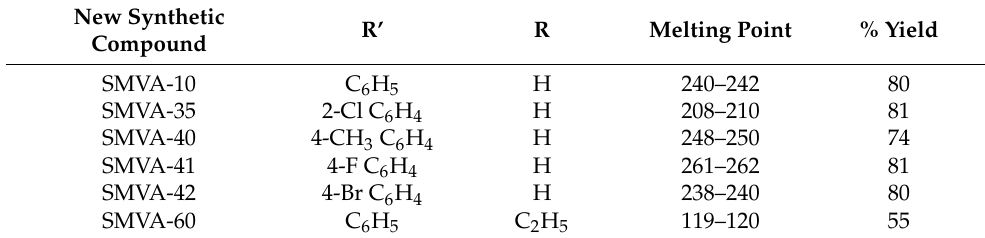
Table 3. Chemical and physical characteristics of the new derivatives of thiazole acetic